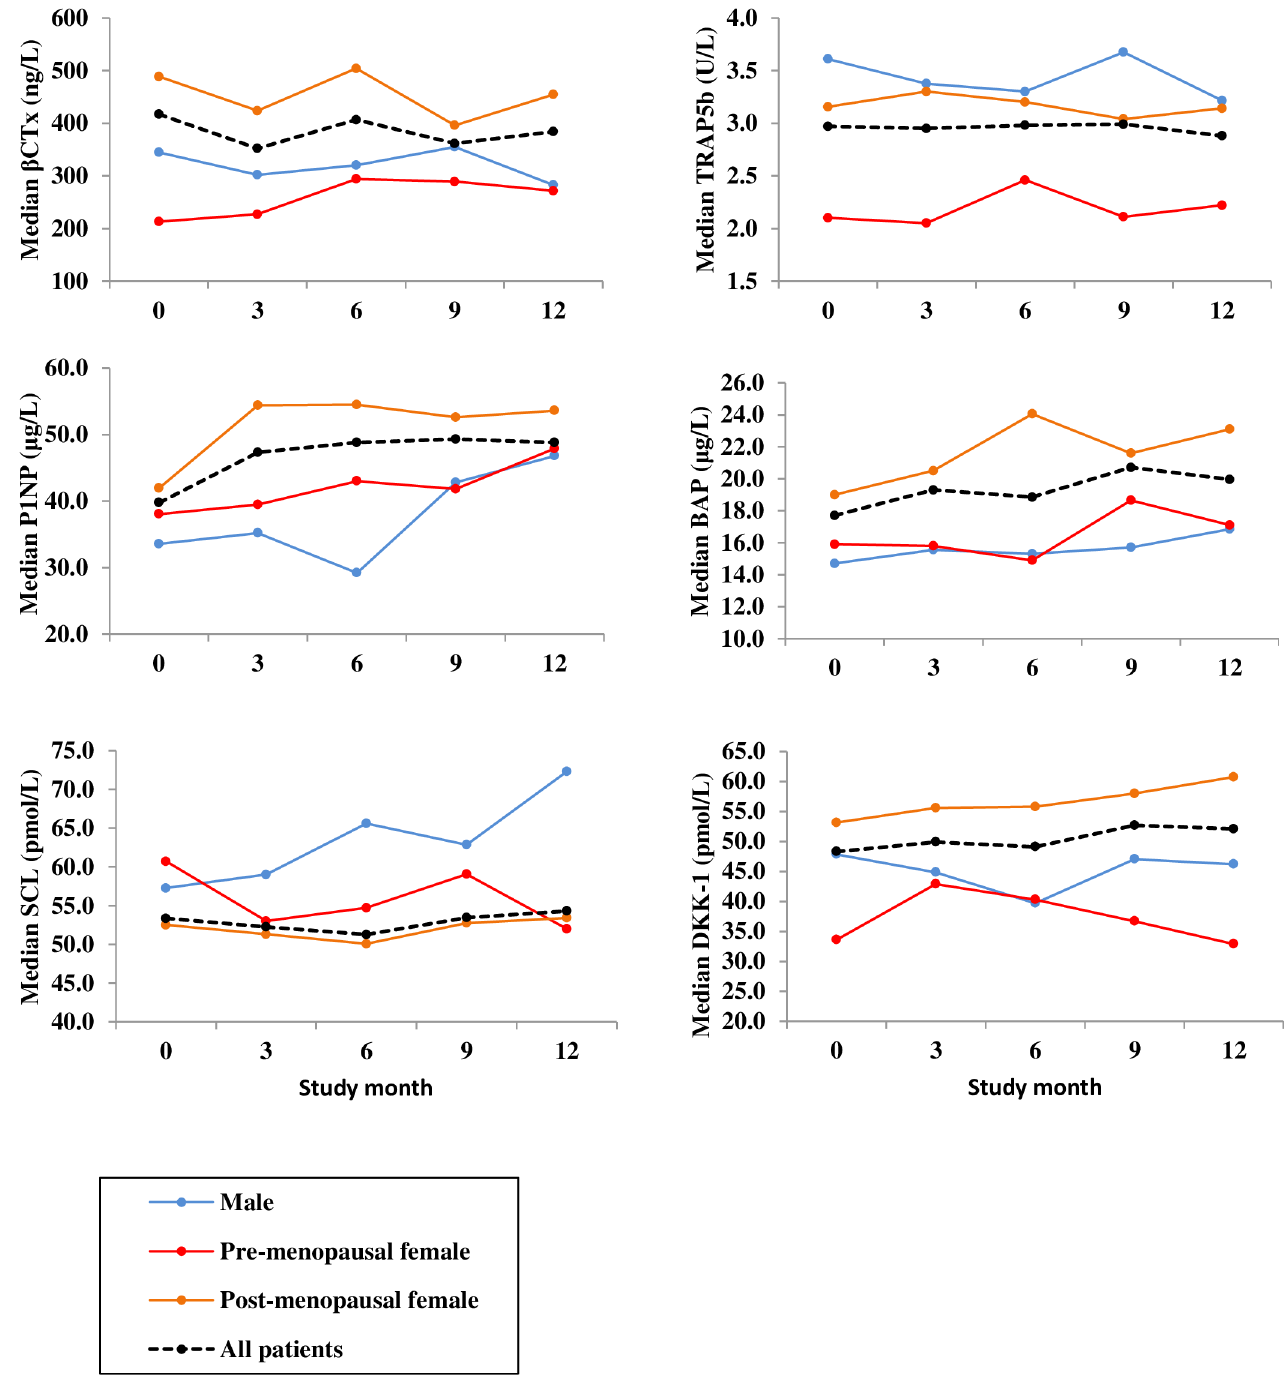
Fig 3. The effects of gender and menopausal status on median levels of biomarkers. Serial blood samples were taken at time 0 before the first rituximab infusion and then at 3 monthly intervals over one year, a second rituximab cycle was given if clinically indicated at 6 months. Median concentrations were plotted at each visit (all patients n = 34; post-menopausal females n = 22; pre-menopausal females n = 6; males n = 6) for the following biomarkers (y axis): β - isomerised carboxy terminal telopeptide of type I collagen ( β CTx); tartrate resistant acid phosphatase isoform 5b (TRAP5b); procollagen type 1 amino-terminal propeptide (P1NP); bone specific alkaline phosphatase (BAP); sclerostin (SCL); dickkopf-related protein 1 (DKK-1).